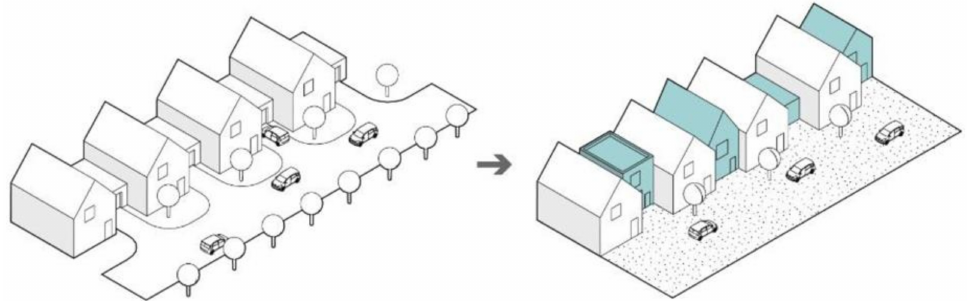
Figure 9. Supposed CAVs’ effect on peripheral areas with lower density [48].